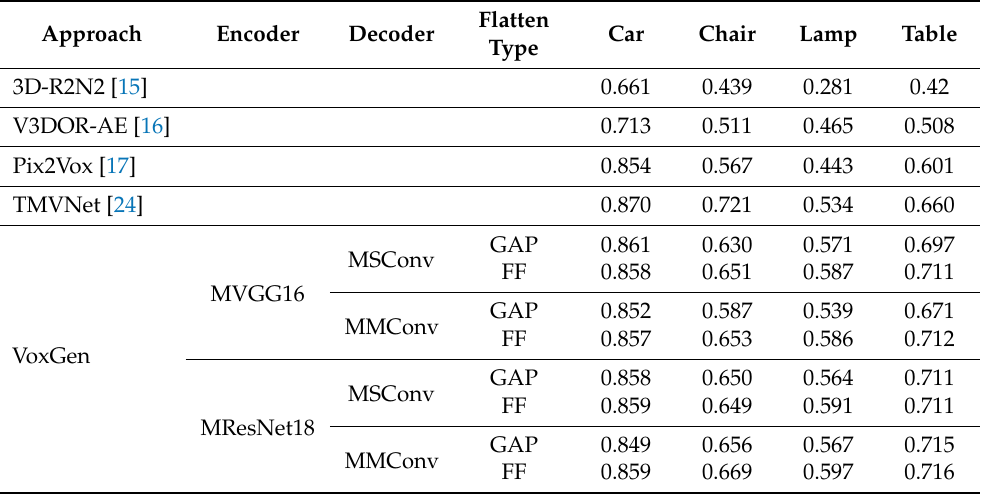
Table 5. Performance comparison between VoxGen and related approaches.